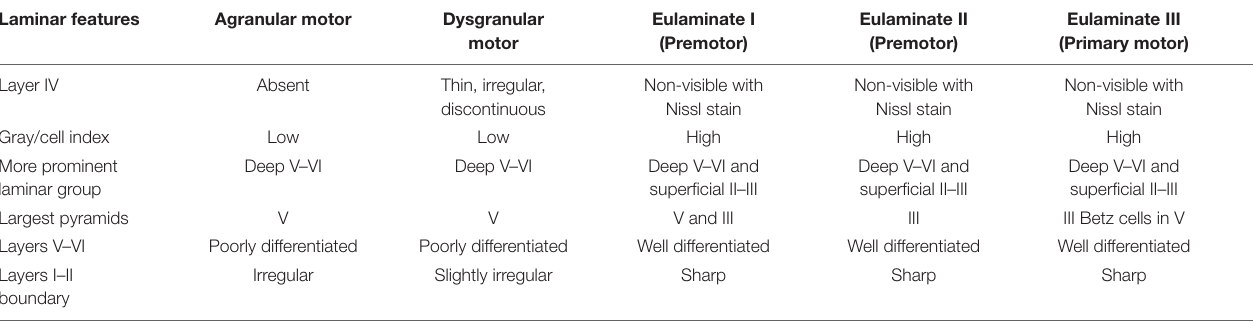
TABLE 3 | Laminar features of cortical types in motor areas of the human frontal cortex.